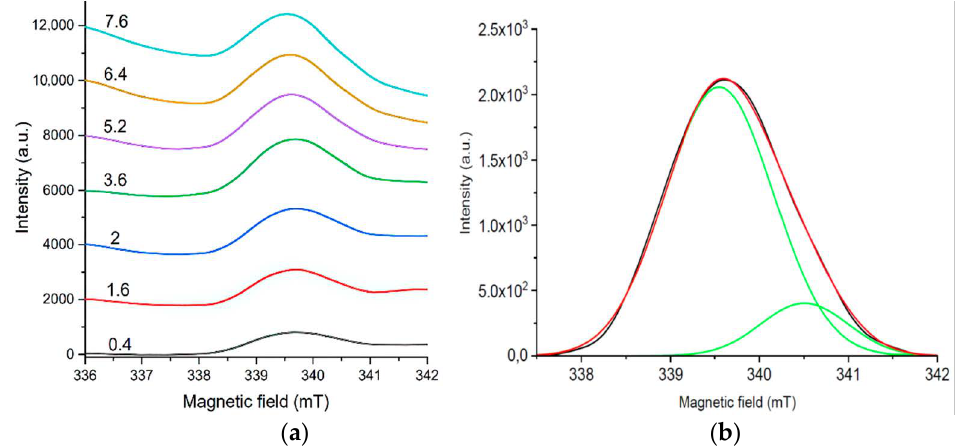
Figure 9. Integrated spectra of the EPR signal saturation for a sample with 25 layers of ZnO coating: ( a ) The power of magnetic field varies from 4.4 to 7.6 mW; ( b ) decomposition into Gaussians of the spectrum at a magnetic field power of 7.6 mW. Table 2. Approximation parameters of the EPR signal for a sample with 25 coating layers, when the spectrum is decomposed into components.